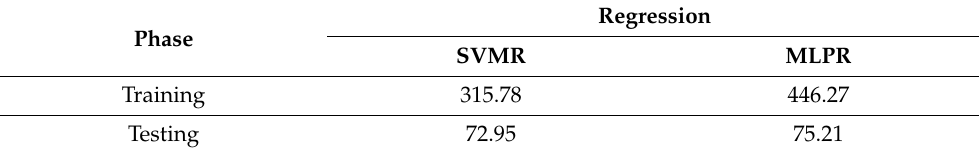
Table 3. Evaluation time for training (including hyperparameter optimization) and